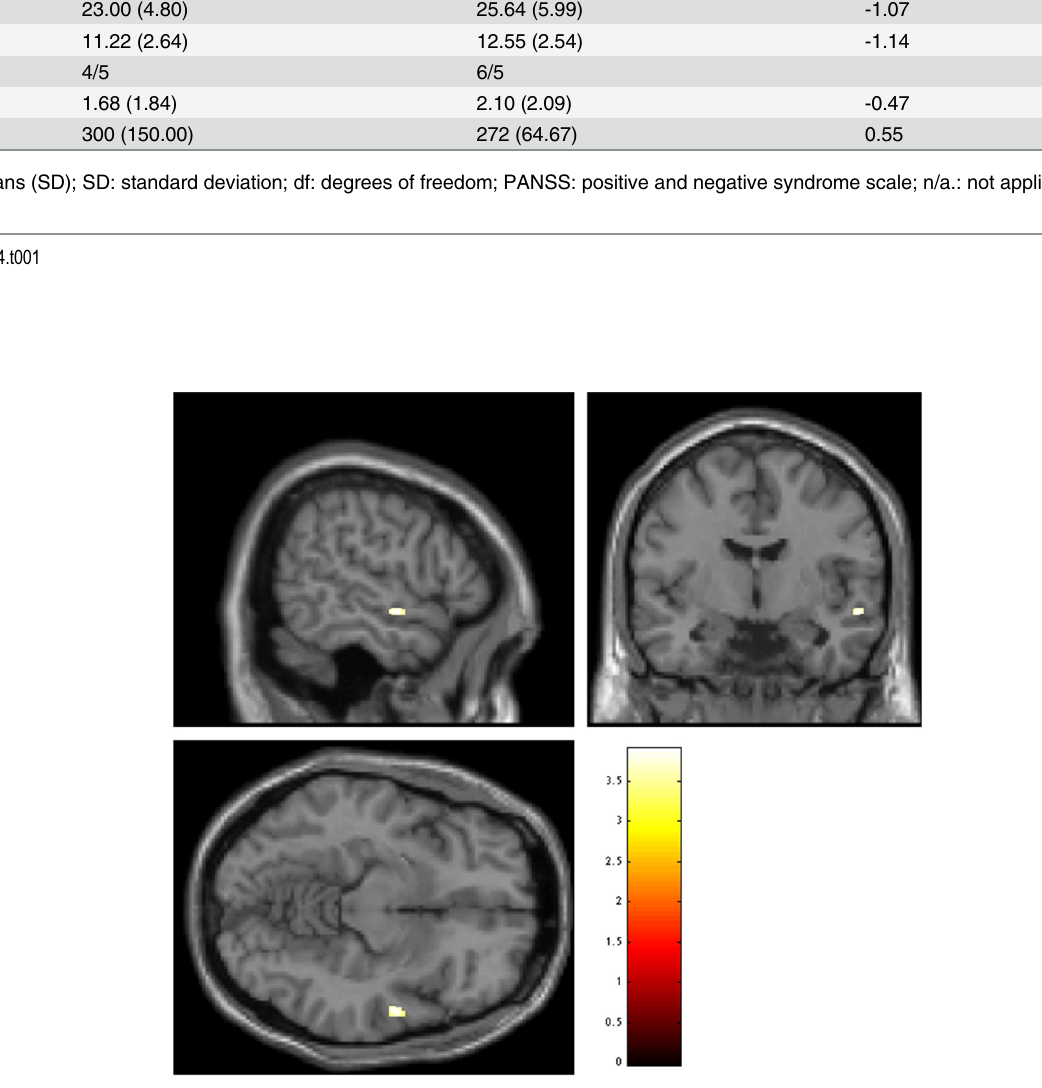
Fig 1. Regions of decreased grey matter volume at baseline in antipsychotic-na ï ve patients with schizophrenia compared to healthy controls. P < 0.001, uncorrected, threshold = 50.